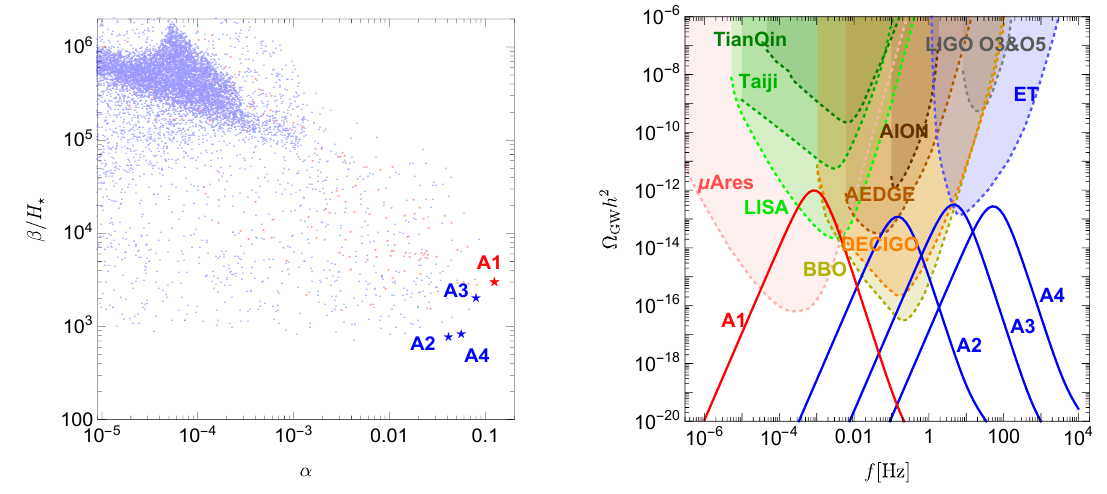
Figure 2 . Quartic potential with zero temperature cubic term. Left panel: scatter plot in the ( α, β/H ) plane. The blue (red) points correspond to the high scale (GeV seesaw scale) scenario. ? Right panel: GW spectra for the four benchmark points in table 1 and marked with stars in the left